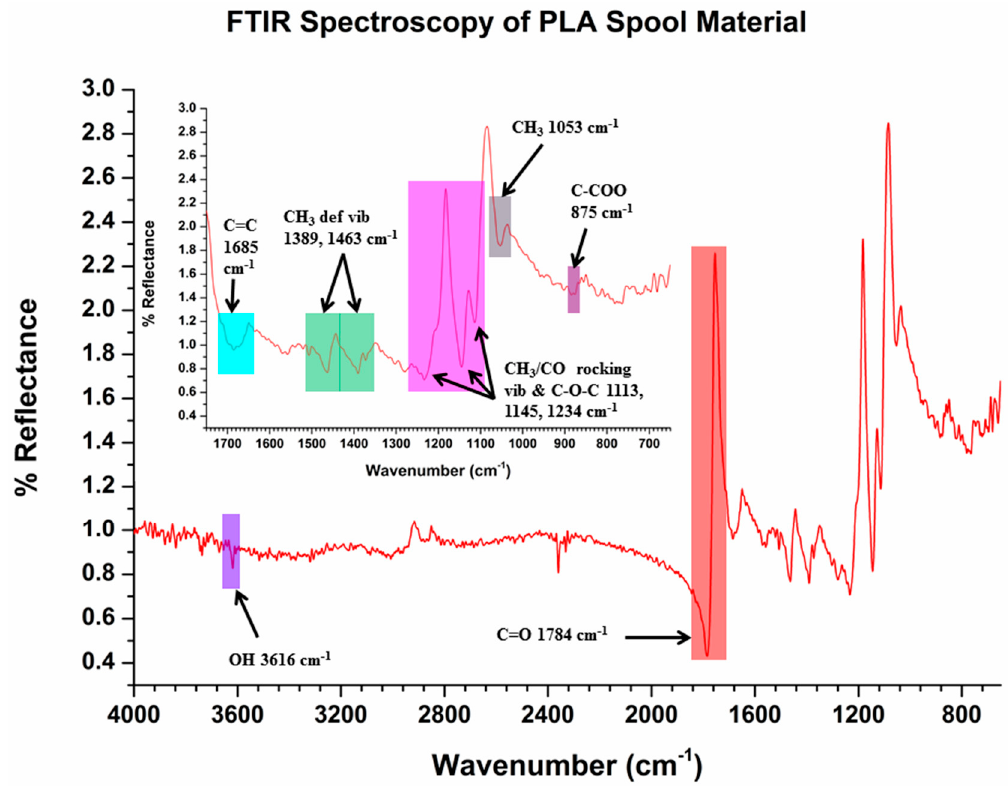
Figure 6. Diffuse Reflectance FTIR (DRIFTS) spectroscopy of PLA spool material as received.